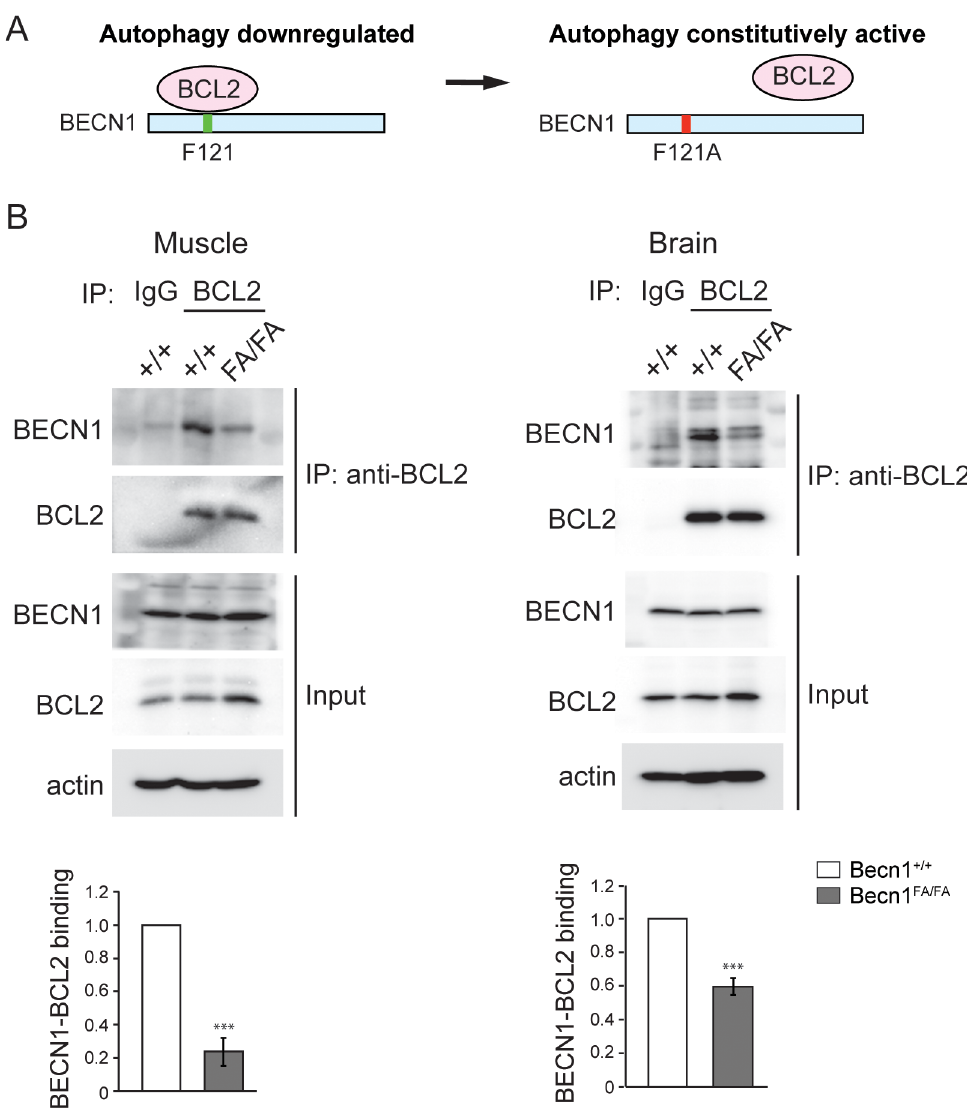
Fig 1. The Becn1 F121A mutation inhibits the BECN1-BCL2 interaction in vivo. (A) Schematic representation of the strategy for hyperactiveautophagy via the Becn1 F121A knockin allele. F121A blocks binding of BECN1 with its inhibitorBCL2, which leads to upregulatedBECN1 function and constitutively high autophagy. (B) Co-immunoprecipitation of BECN1 by BCL2 in skeletal muscle and brain tissues from wild-type(WT) and Becn1 F121A mice. Less BECN1 F121A is immunoprecipitatedby BCL2 than WT BECN1, quantified by the BECN1/ BCL2 ratio in the IP samples from 3 independentexperiments. FA/FA, Becn1 F121A homozygousknock-in mice. *** , P < 0.001,t